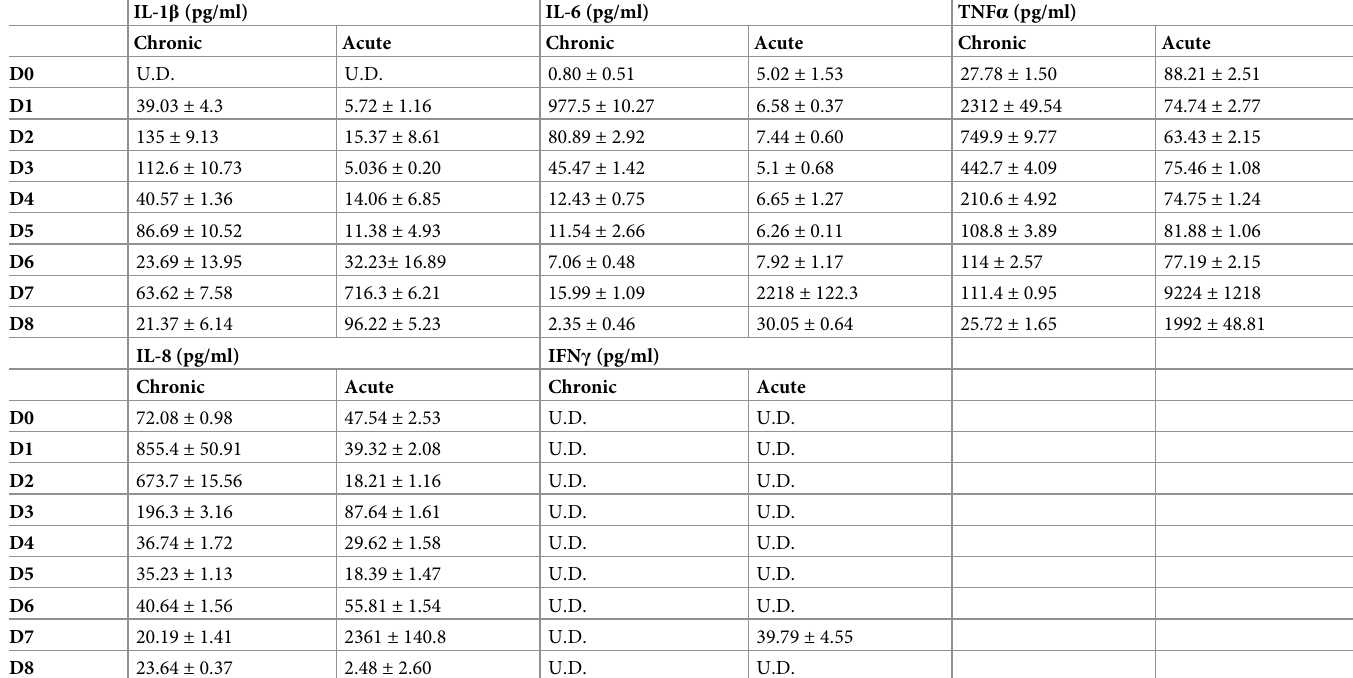
Table 2. Absolute cytokine level after LPS